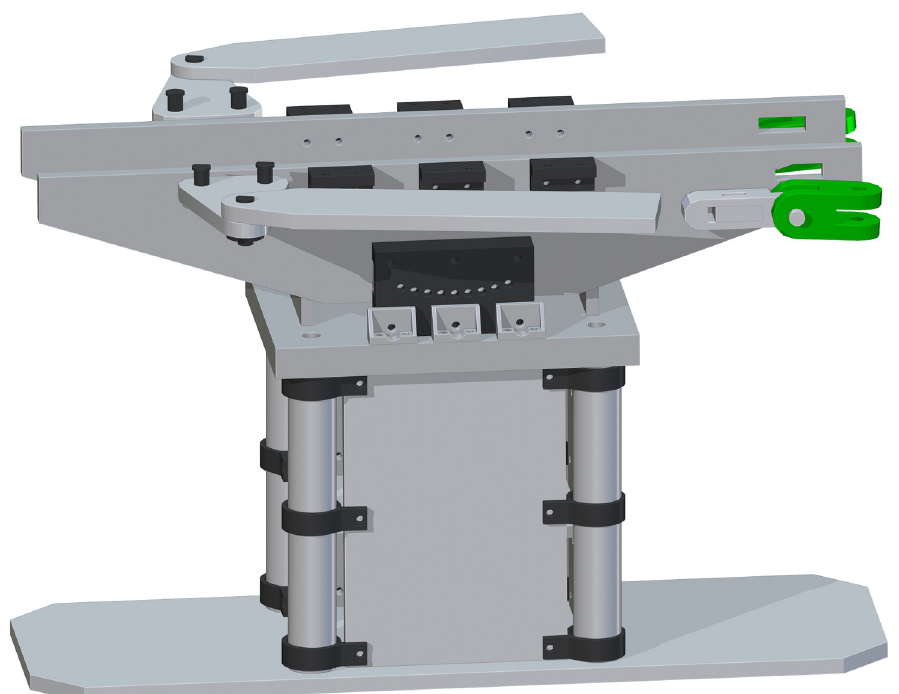
Fig 17. Addition of Leg Multi Pivot to Leg Pivot X-Axis.